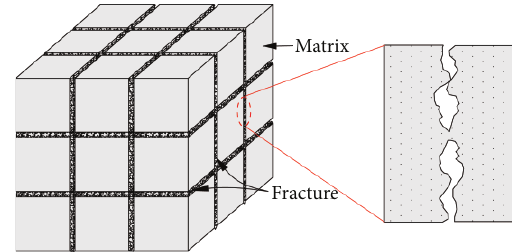
Figure 1: Schematic of coal